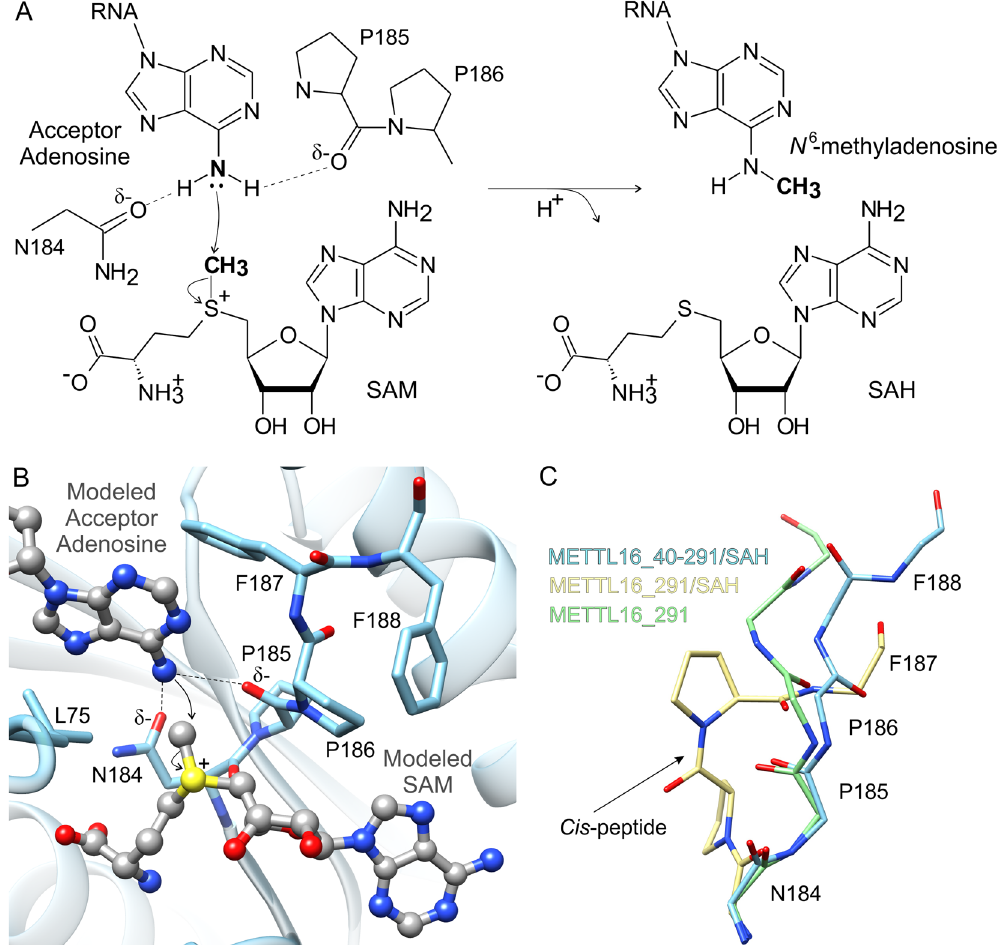
Figure 4. Proposed mechanism of methyl transfer catalyzed by METTL16. ( A ) A schematic of the chemical S N 2 reaction of methyl transfer from SAM to N 6 -adenosine is shown with curved arrows to indicate movement of electron pairs. ( B ) To model methyl transfer, SAM (gray ball-and-stick representation) was modeled into the SAH-binding site of METTL16_40–291 (blue) and the methyl-acceptor adenosine (gray ball-and-stick representation) was modeled via superposition of an m 6 A DNA MTase, EcoP15l (PDB ID: 4zcf, chain B 39 ), from E. coli bound to unmethylated DNA. Residues in the 184 NPPF 187 motif that are critical for catalysis are labeled. ( C ) Comparison of the apo METTL16_291 (green sticks), SAH-bound METTL16_291 (yellow sticks) and SAH-bound METTL16_40–291 (PDB ID: 2h00 27 , blue sticks) structures revealed different backbone conformations of the 184 NPPFF 188 motif; residue F188 could not be modeled in the METTL16_291/SAH structure. Side chains of P185 and P186 of METTL16_291/SAH are shown while the others have been removed for clarity. An arrow points to the cis -conformation between P185 and